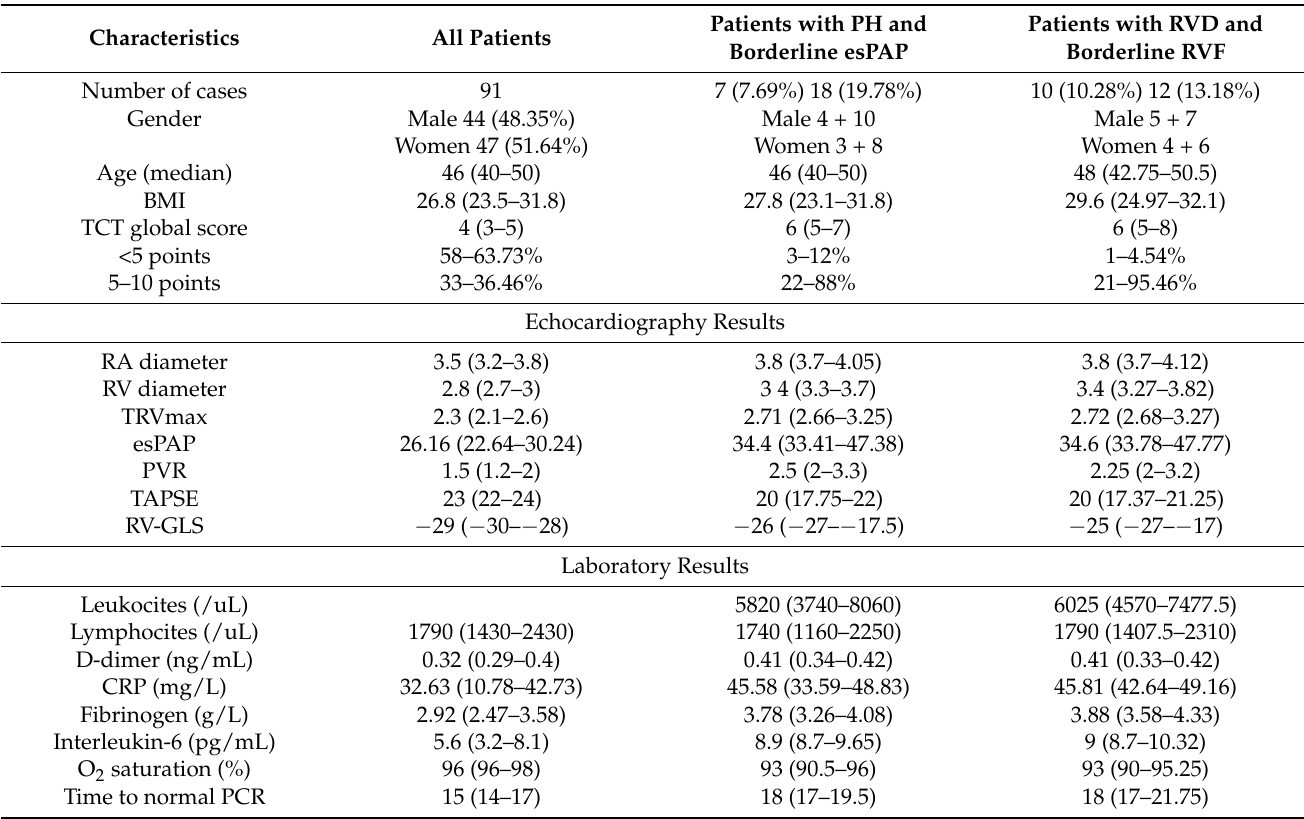
Table 1. Demographic and clinical characteristics of the study population.